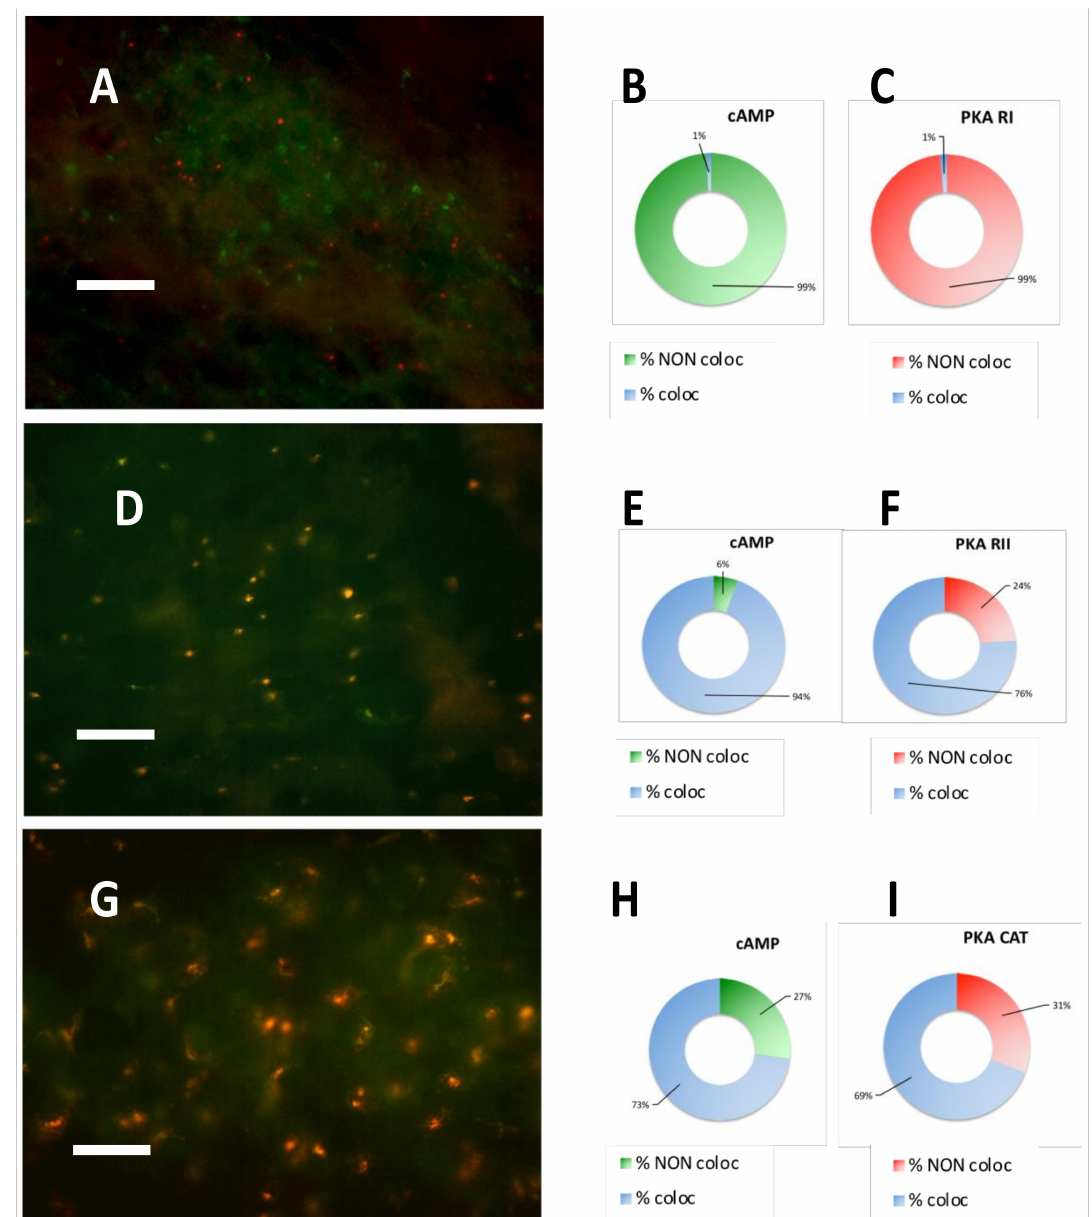
Figure 3. Case 5 representative images. ( A ) Merging of PKA RI immunofluorescence (red) and SAF-cAMP labelling (green): the signals are clearly separated (see original single channel images in Figure S4A,B). ( B ) Percentage of colocalization (blue) or non-colocalization (green) of cAMP with PKA RI, relative to Figure 3A. ( C ) Percentage of colocalization (blue) or non-colocalization (red) of PKA RI with cAMP, relative to Figure 3A. ( D ) Merging of PKA RII immunofluorescence (red) and SAF-cAMP labelling (green): the signals coincide as shown by the yellowish labelling (see original single channel images in Figure S4C,D). ( E ) Percentage of colocalization (blue) or non-colocalization (green) of cAMP with PKA RII, relative to Figure 3D. ( F ) Percentage of colocalization (blue) or non-colocalization (red) of PKA RII with cAMP, relative to Figure 3D. ( G ) Merging of PKA catalytic subunit immunofluorescence (red) and SAF-cAMP labelling (green): the signals coincide, as shown by the orange-yellowish color (see original single channel images in Figure S4E,F). ( H ) Percentage of colocalization (blue) or non-colocalization (green) of cAMP with PKA catalytic subunit (CAT), relative to Figure 3G. ( I ) Percentage of colocalization (blue) or non-colocalization (red) of PKA catalytic subunit with cAMP, relative to Figure 3G. 100x objective, bar = 10 µ m. Unaltered